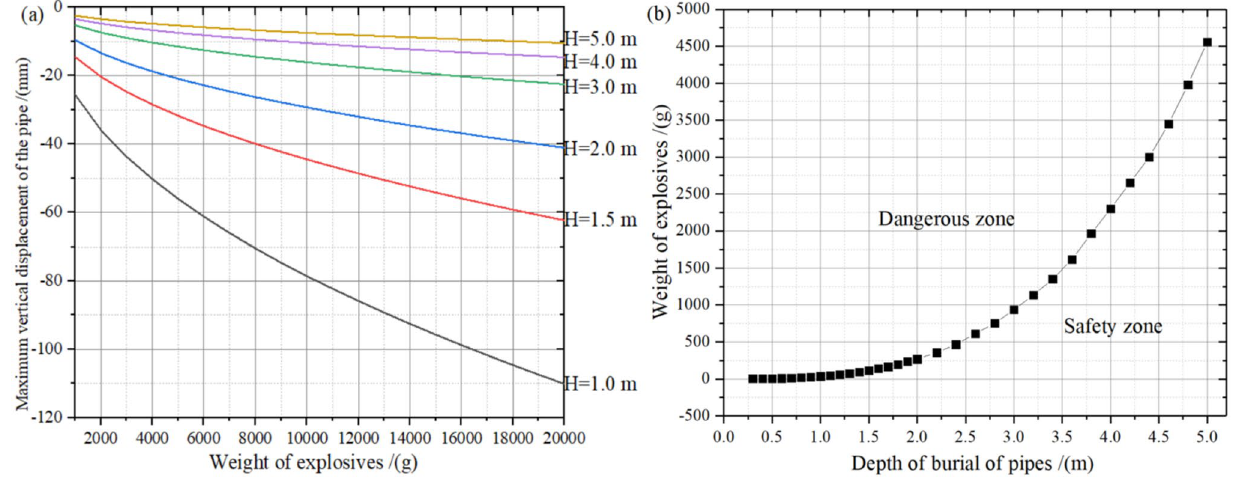
Figure 9. Change of maximum vertical displacement of the pipeline under surface explosive loads under different working